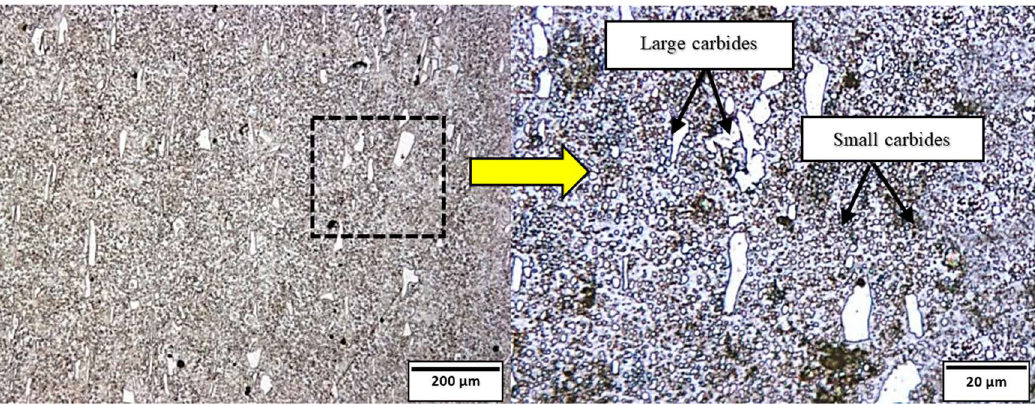
Figure 5. Optical microstructure of as received AISI D2 tool steel.